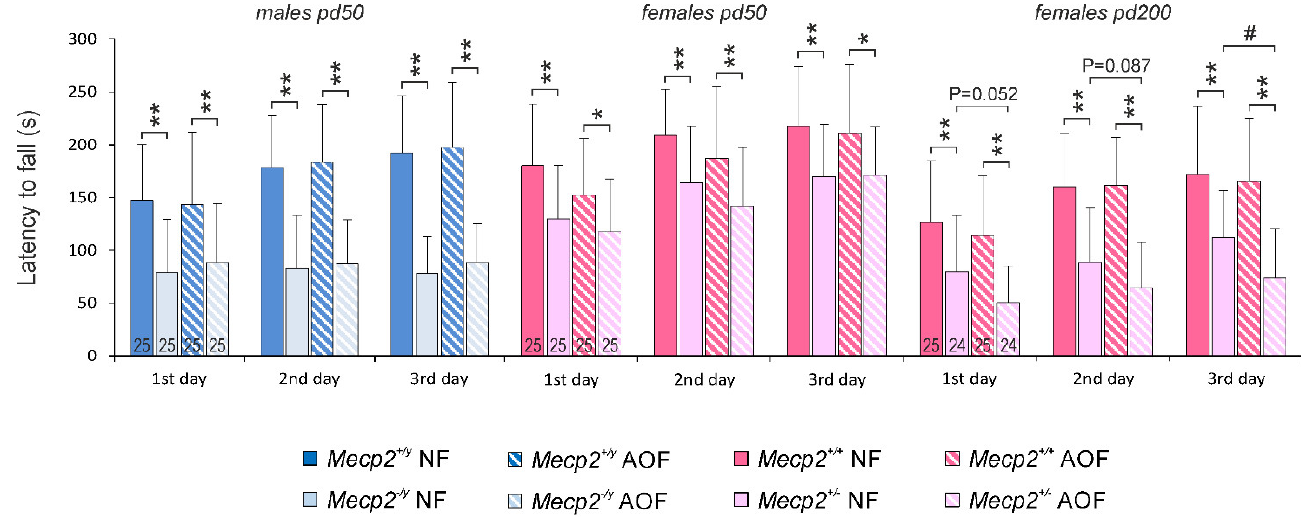
Figure 2. Rotarod testing revealed poor motor coordination in Mecp2 -mutant mice but no beneficial effects of AO treatment. Plotted are the average durations the mice stayed on the rod. The test was conducted on 3 consecutive days. While the performance of WT mice improved over the 3 days, no such improvement was seen in Mecp2 −/ y mice. On pd 200, the long-term AO-treated Mecp2 +/− mice performed even worse than untreated Mecp2 +/− mice. Significant differences were assessed by two-way ANOVAs and Holm–Sidak post-hoc tests and are indicated by asterisks (* p < 0.05, ** p < 0.01). Treatment-related differences among Mecp2 +/− mice are indicated by crosshatches (# p < 0.05).